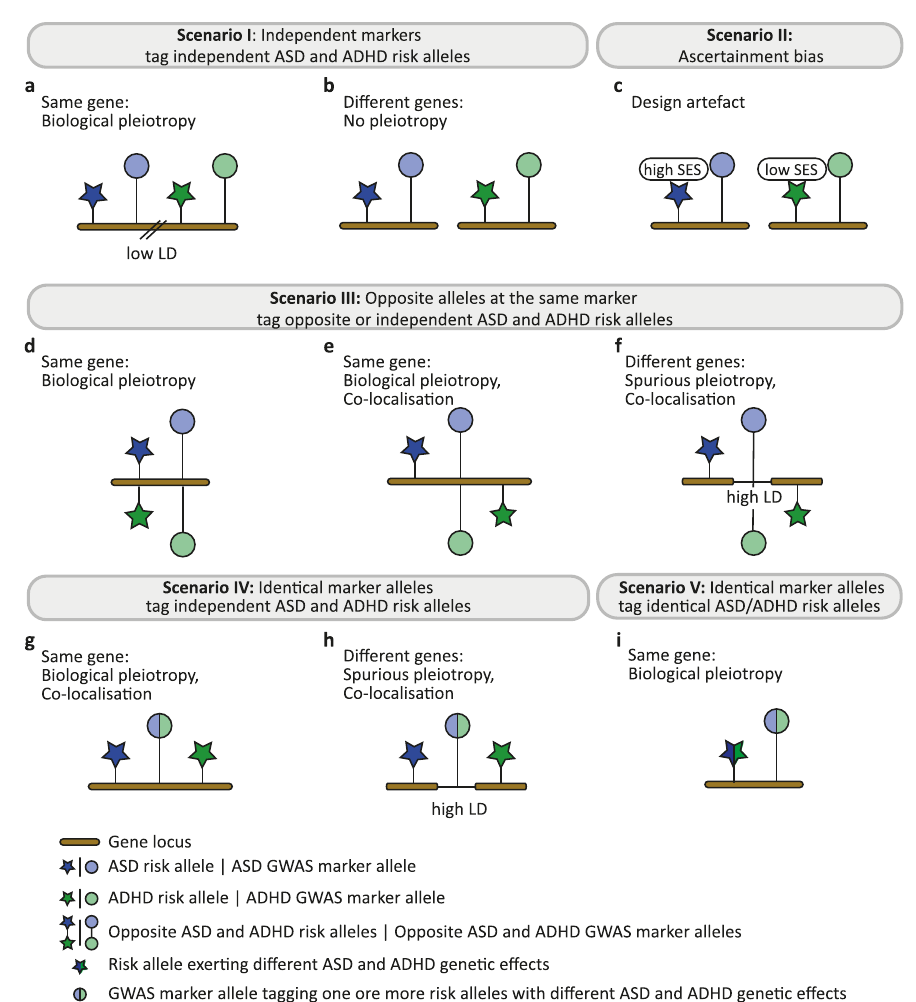
Fig. 1 Candidate mechanisms underlying discordant genetic association patterns with educational attainment. Discordant associations with educational attainment, such as observed for ASD versus ADHD risk, may arise due to different mechanisms. Scenario I: Independent markers tag independent ASD and ADHD risk alleles, either ( a ) at the same gene locus in regions with low linkage disequilibrium (LD) or ( b ) at different loci. ( c ) Scenario II: Ascertainment bias during the recruitment of cases may lead to an arti fi cial association of ASD with higher socio-economic status (SES) and ADHD with lower SES (non-testable). Scenario III: Opposite alleles at the same marker may tag opposite ASD and ADHD risk alleles at ( d ) a single risk variant, or independent ASD and ADHD risk alleles within ( e ) the same gene or ( f ) different genes in high-LD regions. Scenario IV: Identical marker alleles tag independent ASD and ADHD risk alleles, either ( g ) within the same gene or ( h ) at different genes in high-LD regions. ( i ) Scenario V: Identical marker alleles tag identical ASD/ADHD risk alleles (biological pleiotropy). Within each sub fi gure, one or more observed marker allele is shown in linkage disequilibrium with one or more ASD and ADHD risk allele. ADHD Attention-De fi cit/Hyperactivity Disorder, ASD Autism Spectrum Disorder, GWAS genome-wide association study, LD, linkage disequilibrium, SES socio-economic status. Table 1 Sample